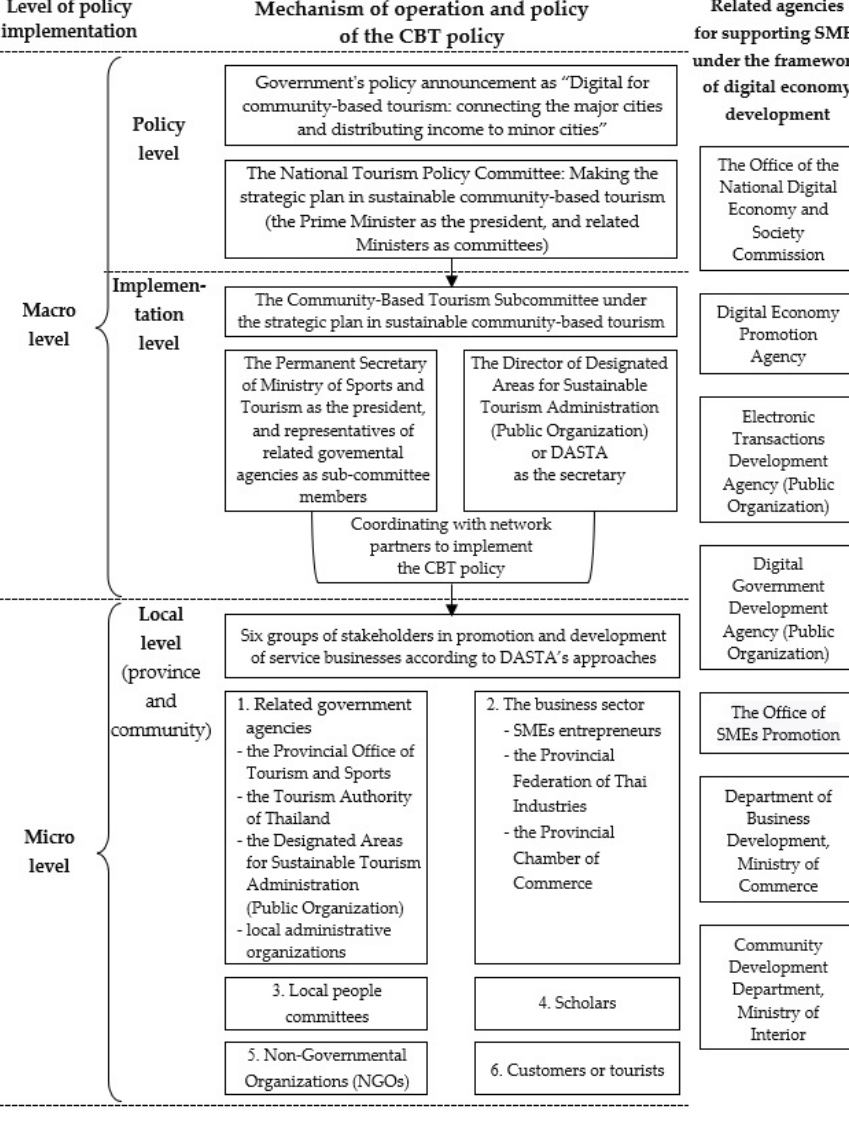
Figure 2. Level of policy implementation, mechanism of operation, actors, and related agencies for supporting SMEs.